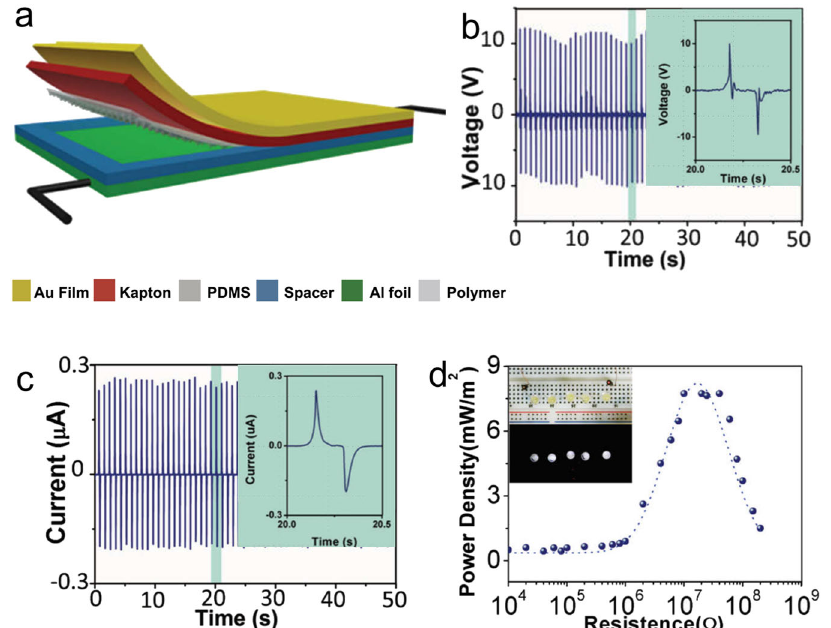
Fig. 2 a Structure of iTENG. b Output voltage of the iTENG. c Output current. d Dependence of output power density on the loading resistances. Reproduced with permission. 27 Copyright 2014